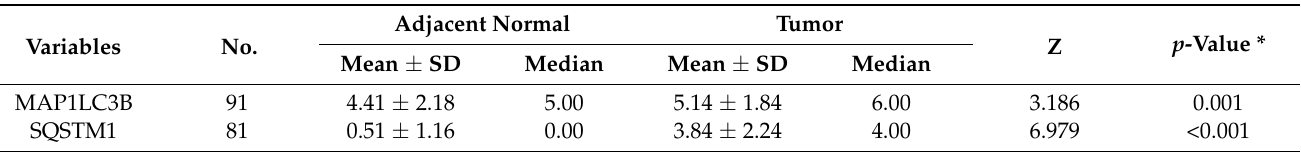
Table 1. The comparison of MAP1LC3B and SQSTM1 expression between adjacent normal and tumor tissues in IDC patients.